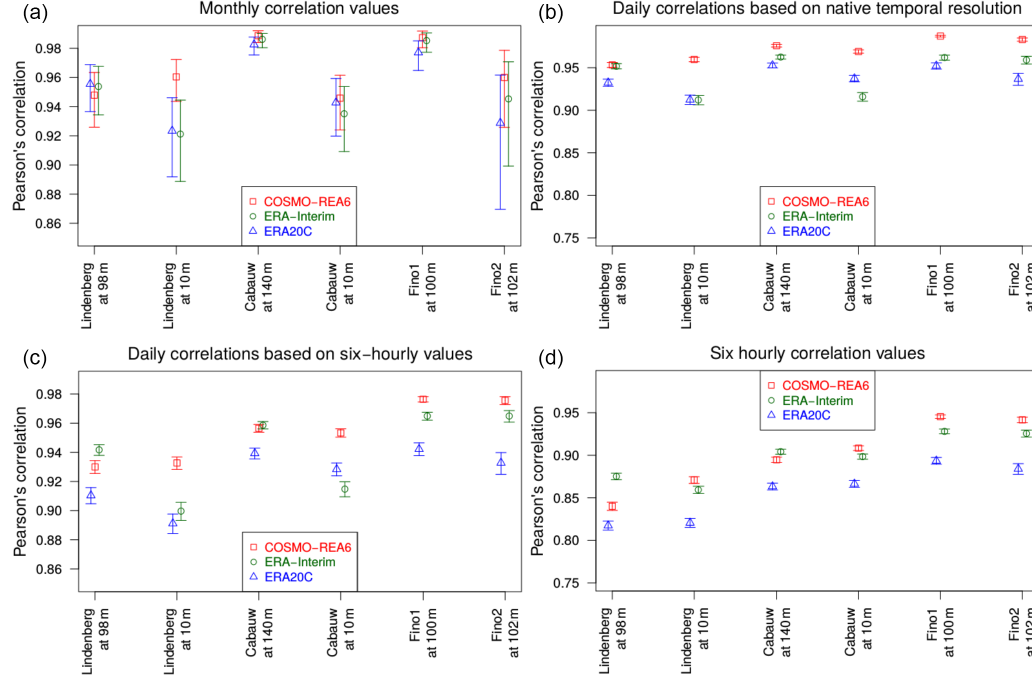
Figure 5. Pearson’s correlation for monthly mean wind speed (top left), for daily mean wind speed on the native temporal resolution (top right), for daily mean wind speed of six-hourly values (bottom left), and for six-hourly mean wind speed (bottom right) between tower measurements and reanalyses. Shown is the 95% confidence interval for each correlation value.